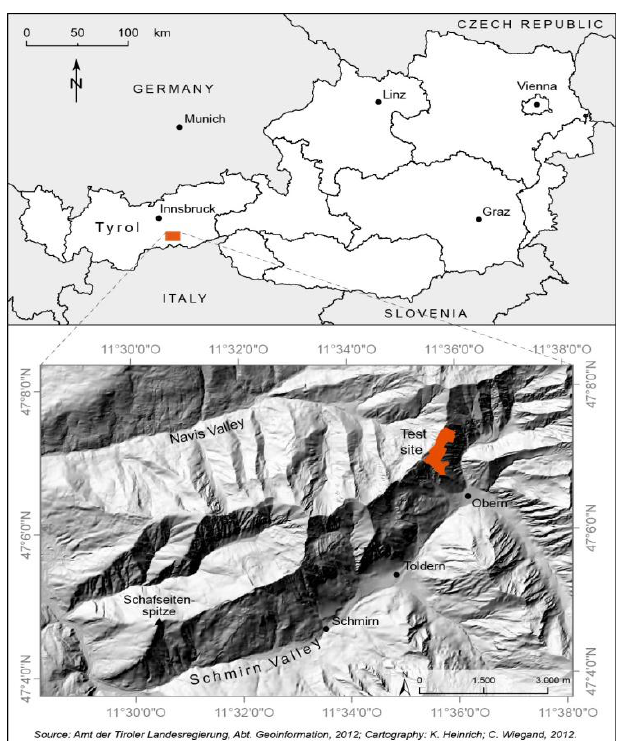
Figure 1. Location of the test site in Tyrol,